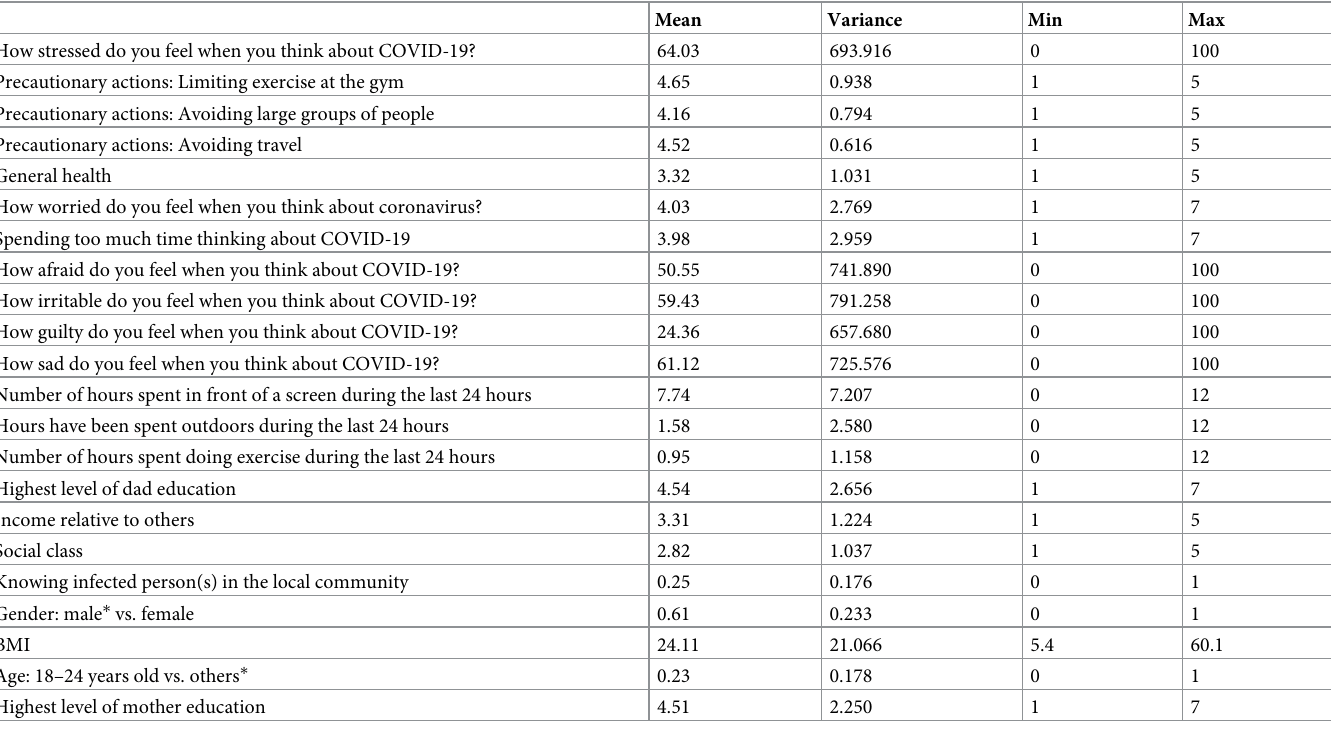
Table 1. Variables incorporated in statistical